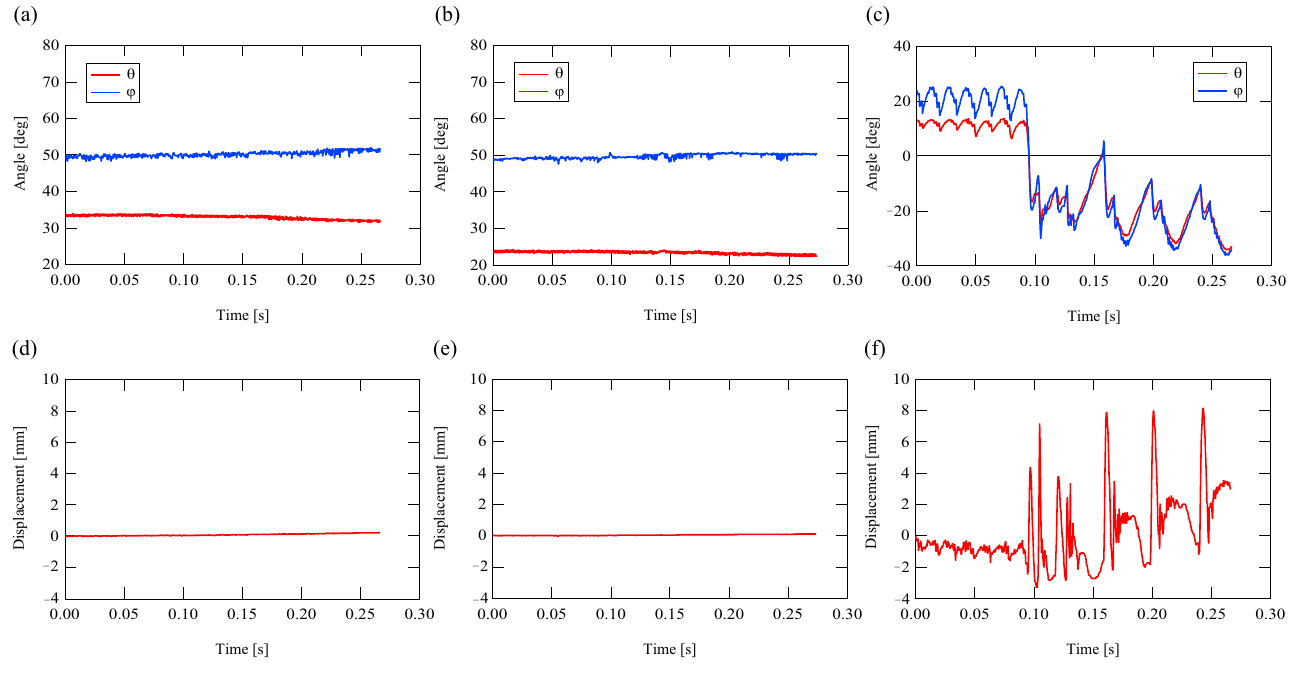
Figure 11. Experimental results during wiping process with zero and nonzero attack angles. ( a ) Angular displacements of two links with zero attack angle. ( b ) Angular displacements of two links with 10-degree attack angle. ( c ) Angular displacements of two links with 18-degree attack angle. ( d ) Variation of y -coordinate of the tip with zero attack angle. ( e ) Variation of y -coordinate of the tip with 10-degree attack angle. ( f ) Variation of y -coordinate of the tip with 18-degree attack angle.